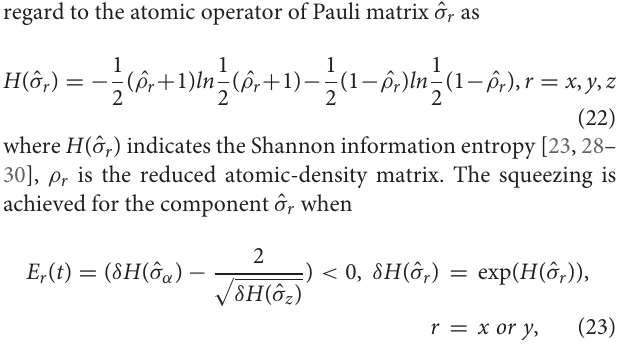
and c + = 0.5. The function shows more regular oscillations and reaches pure states at n π , as shown in Figure 2C ). When the parameter λ 3 is added to the cavity interaction, the function has the minimum values for the intervals of revivals (see Figure 2D